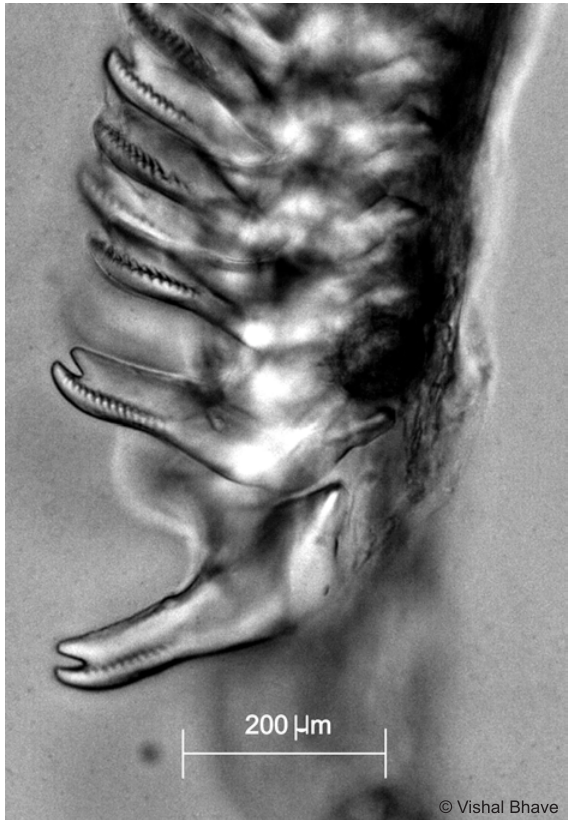
Image 6. Egg case